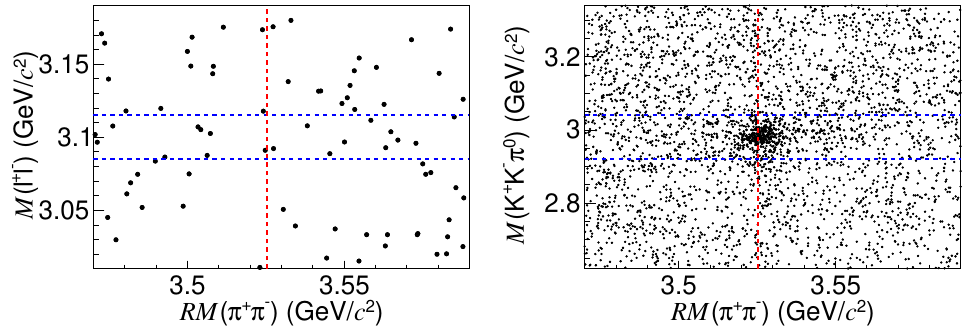
Figure 1 . Distributions of M ( ‘ + ‘ − ) versus RM ( π + π − ) for h c → π 0 J/ψ (left panel) and M ( K + K − π 0 ) versus RM ( π + π − ) for h c → γη c (right panel). The horizontal dashed lines de- note the signal regions of the J/ψ (left) and η c (right), and the vertical dashed lines mark the nominal h c